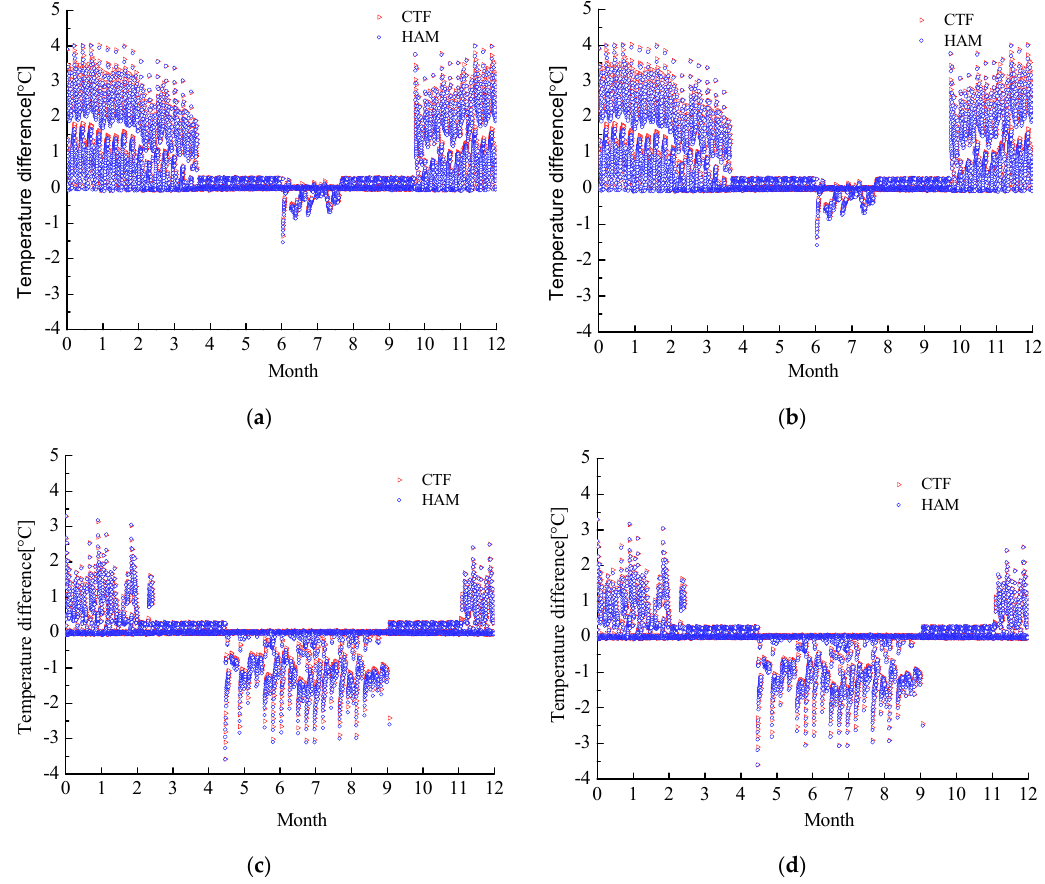
Figure 6. Air temperature and surface average temperature difference in the 101 room in different cities: ( a ) Harbin (Wall NO.1—EPS); ( b ) Harbin (Wall NO.2—Rock Wool); ( c ) Guangzhou (Wall NO.1—EPS); ( d ) Guangzhou (Wall NO.1—Rock Wool).